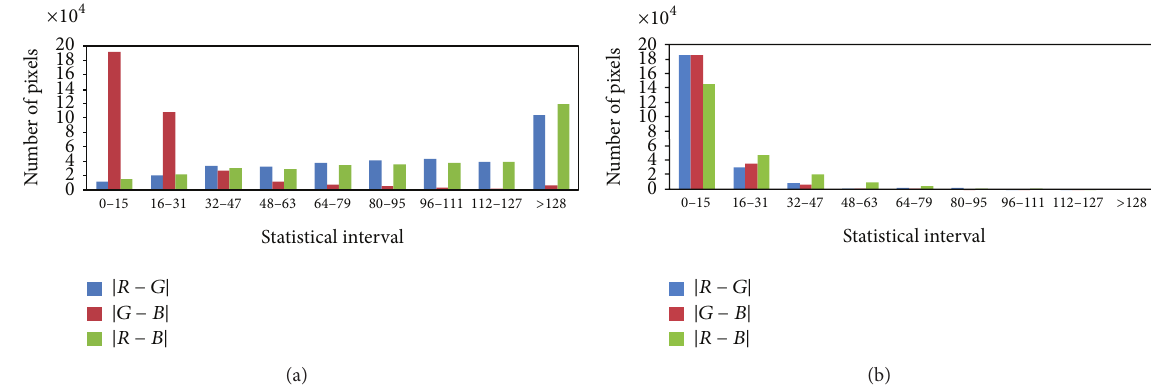
Figure 3: Comparison of RGB components between taillights and the other parts of vehicles.